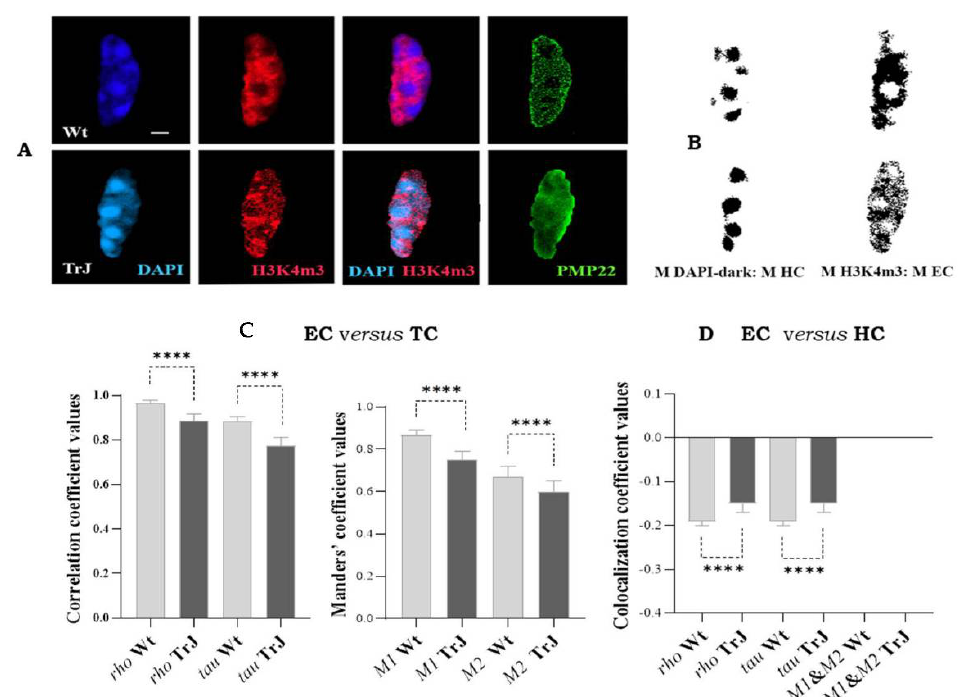
Figure 5. Colocalization analysis of euchromatin and heterochromatin in Schwann cell nuclei. ( A ): Images of Wt and TrJ SC nuclei showing DAPI (blue), euchromtic H3K4m3 (red) and PMP22 (green) signals. ( B ): Respectively mask images of heterocromatin (M HC) and euchromatin (M EC), obtained using the threshold tool of Fiji. ( C ): Colocalization between euchromatin (EC) and total chromatin (TC). M1 : fraction of EC (H3K4m3 signal) in TC (DAPI-light + DAPI-dark signals), and M2 : fraction of TC in EC. ( D ): Colocalization between EC (M H3K4m3) and HC (M DAPI-dark). M1 : fraction of EC (M H3K4m3) in HC (M DAPI−dark), and respectively M2 : fraction of HC (M DAPI-dark) in EC (M H3K4m3). Rho and tau correlations and M1 and M2 co-occurrence coefficients were estimated employing Fiji Coloc 2 plugins with Costes p -values > 95%. The bar diagrams illustrate the medians and 95% confidence intervals of the coefficients. Scale bar = 2µm. Differences between Wt and TrJ were established applying Mann–Whitney tests (**** p -values < 0.0001) in 100 SC nuclei per geno- type. As expected, in both Wt and SC nuclei, EC colocalizes with TC and anticolocalizes with HC, both relationships being significantly stronger in Wt than TrJ SC nuclei.